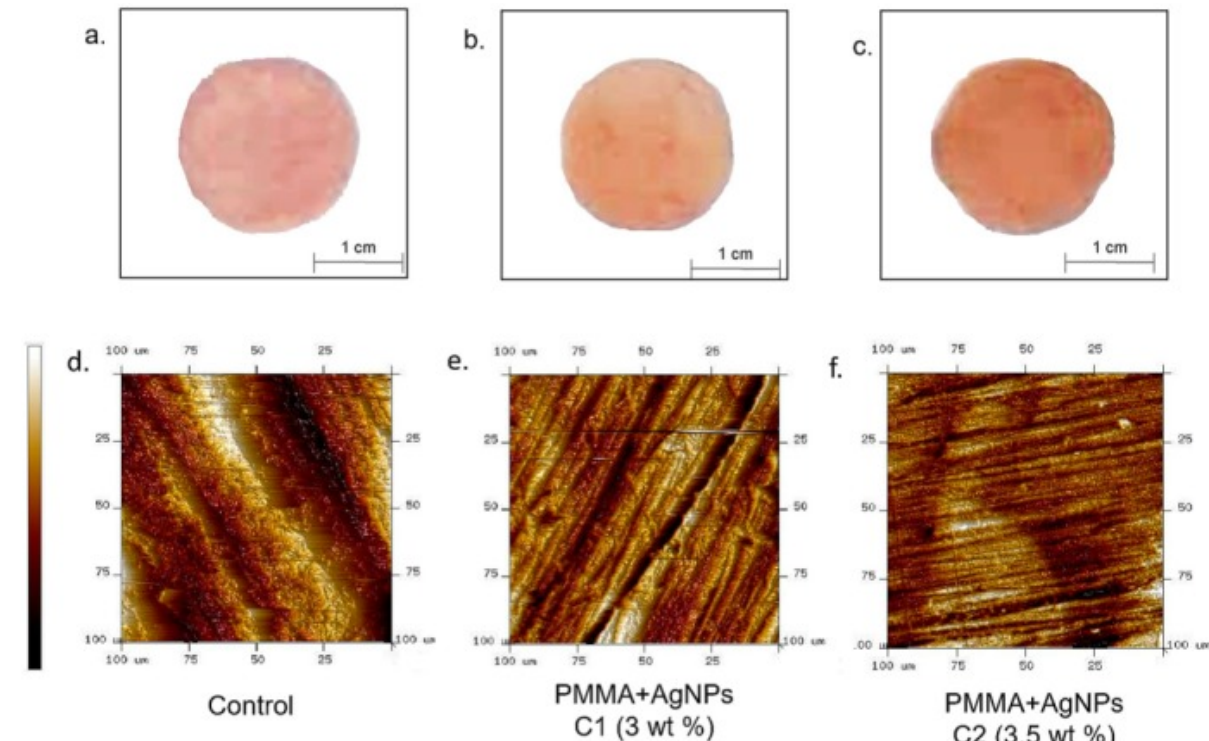
Figure 3. Images of PMMA without NPs (control) ( a ); PMMA + AgNPs (3 wt%) ( b ) and PMMA + AgNPs (3.5 wt%) ( c ): The color became darker with increasing concentrations of the NPs. AFM topographical images of PMMA without NPs added (control) ( d ); PMMA + AgNPs (3 wt%) ( e ) and PMMA + AgNPs (3.5 wt%) ( f ). Reprinted from ref. [95], copyright 2019, MDPI.